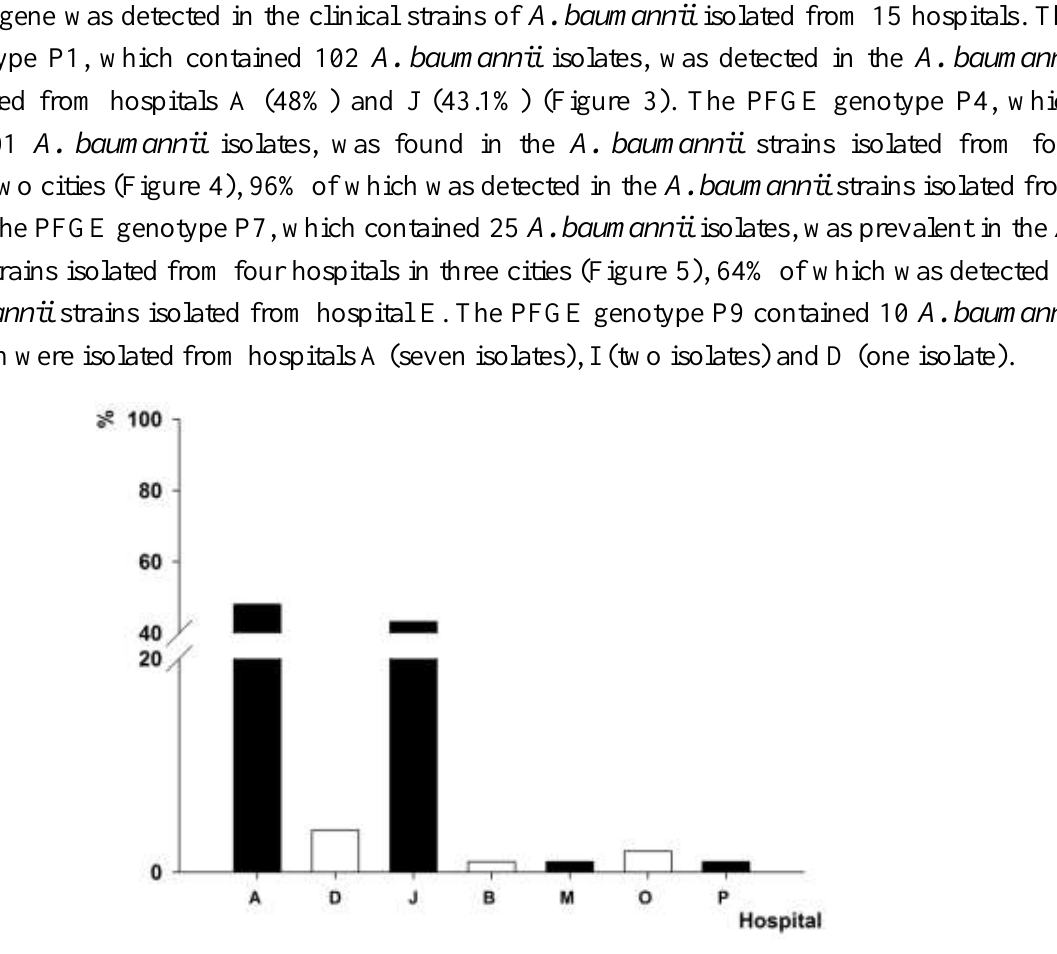
Figure 3. Distribution of A. baumannii isolates with PFGE genotype P1.